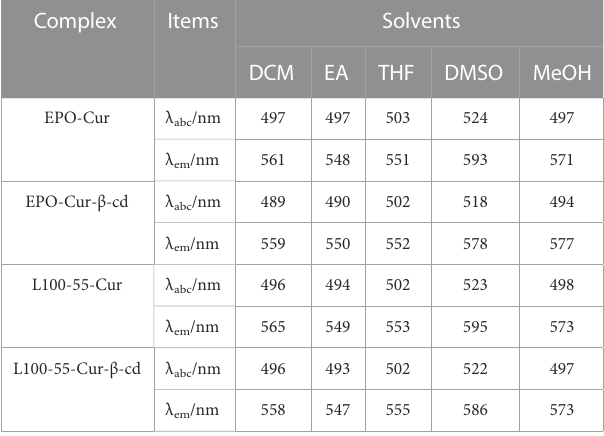
TABLE 1 Absorption and emission spectra data in different solutions of four complexes.